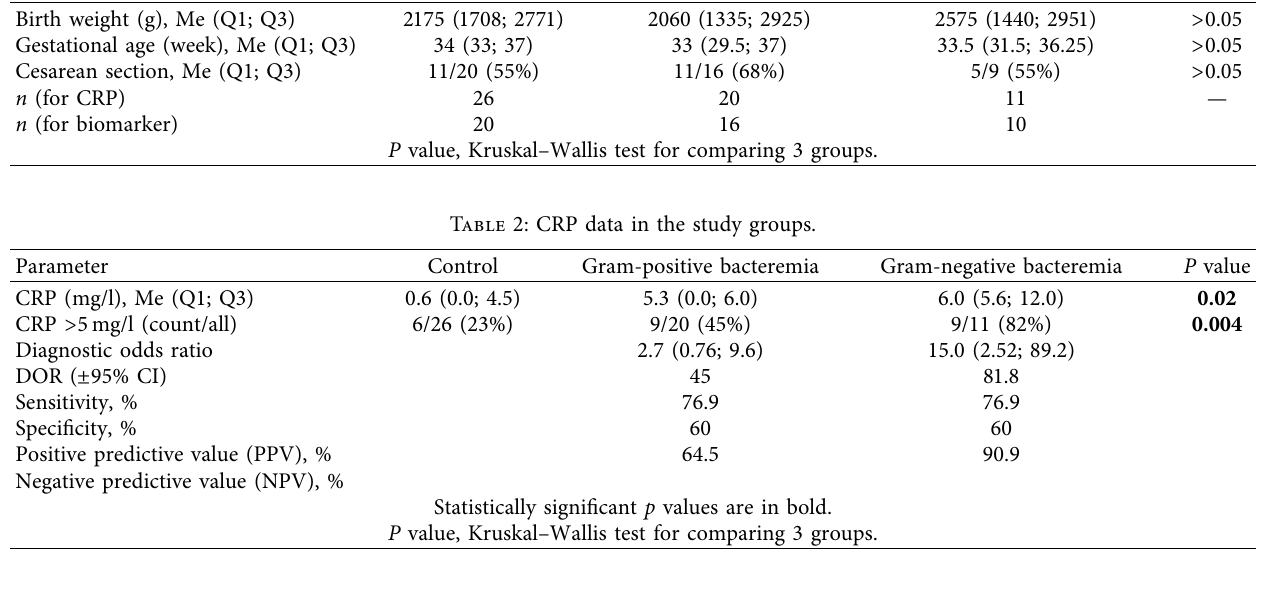
Table 3: The main indicators of leukocytes and